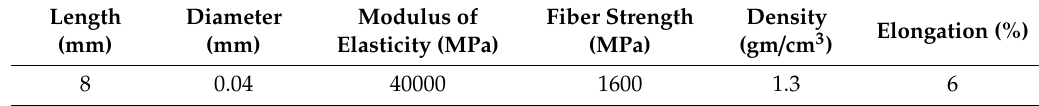
Table 2. Properties of polyvinyl alcohol (PVA) fibers.